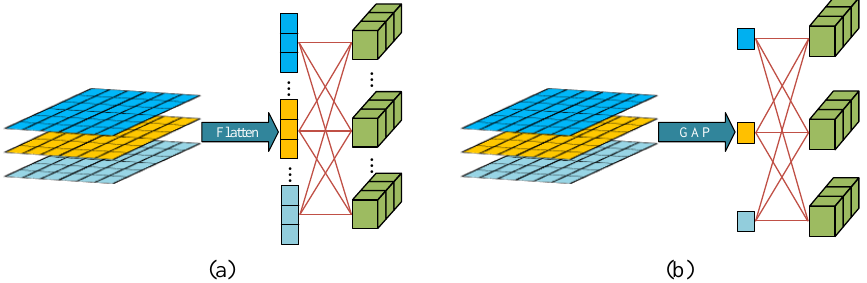
Figure 7. An intuitive comparison between fully connected layer and global average pooling layer for multi-channel 2D